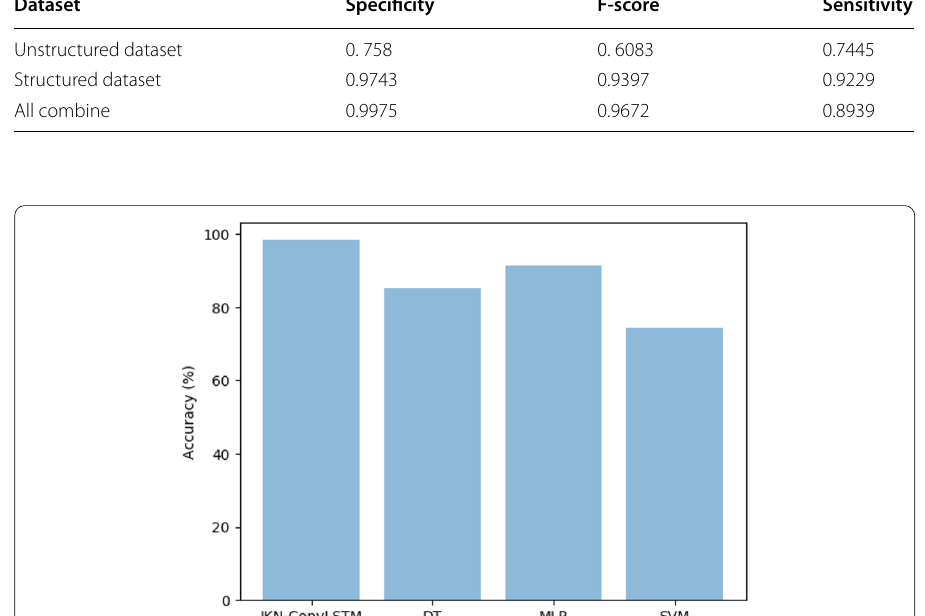
Fig. 10 A comparison of the proposed framework with other